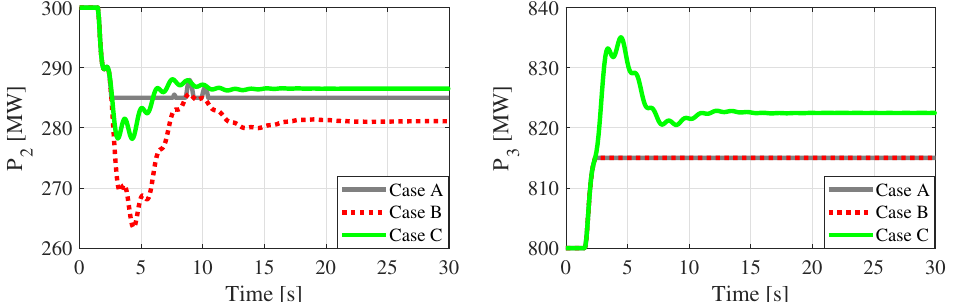
Figure 6. Power fed from VSC2, P 2 , and generated power by the OWF, P 3 , when using AFC from offshore HVDC.